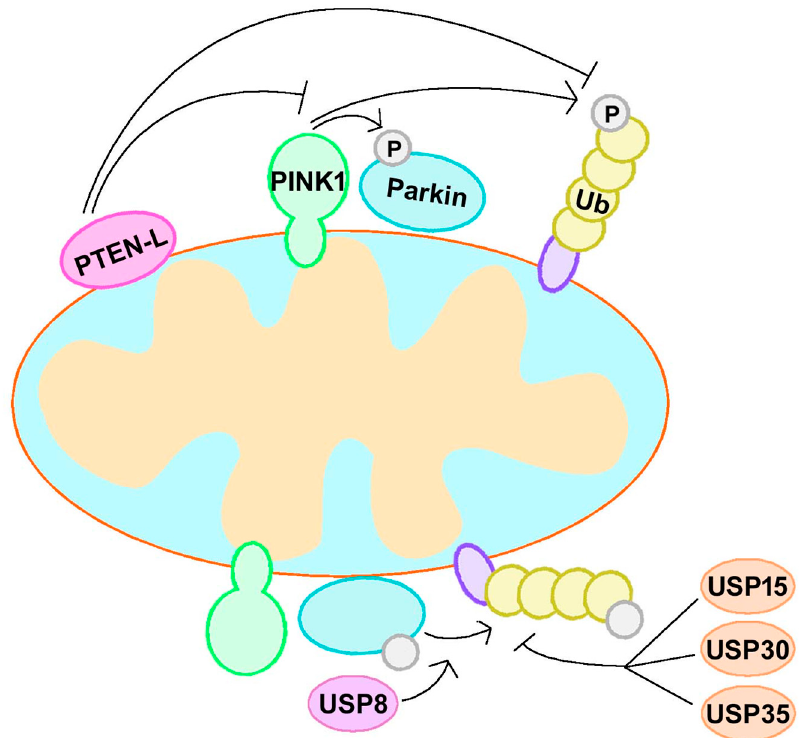
Figure 3. The PINK1–Parkin–Ub feedforward loop. PINK1, Parkin, and Ub form a feedforward mechanism of mitophagy. Regulation of this feedforward loop is a strategy for mitophagy modulation and PD treatment. PTEN-L dephosphorylate p-Ub and suppress mitophagy via blockage of the feedforward mechanism. USP30, USP35, and USP15 can counteract Parkin activity and regulate mitophagy negatively, while USP8 regulate Parkin and mitophagy positively. PTEN-L, phosphate and tension homology deleted on chromsome ten-long; Ub, ubiquitin; USP, ubiquitin specific protease.